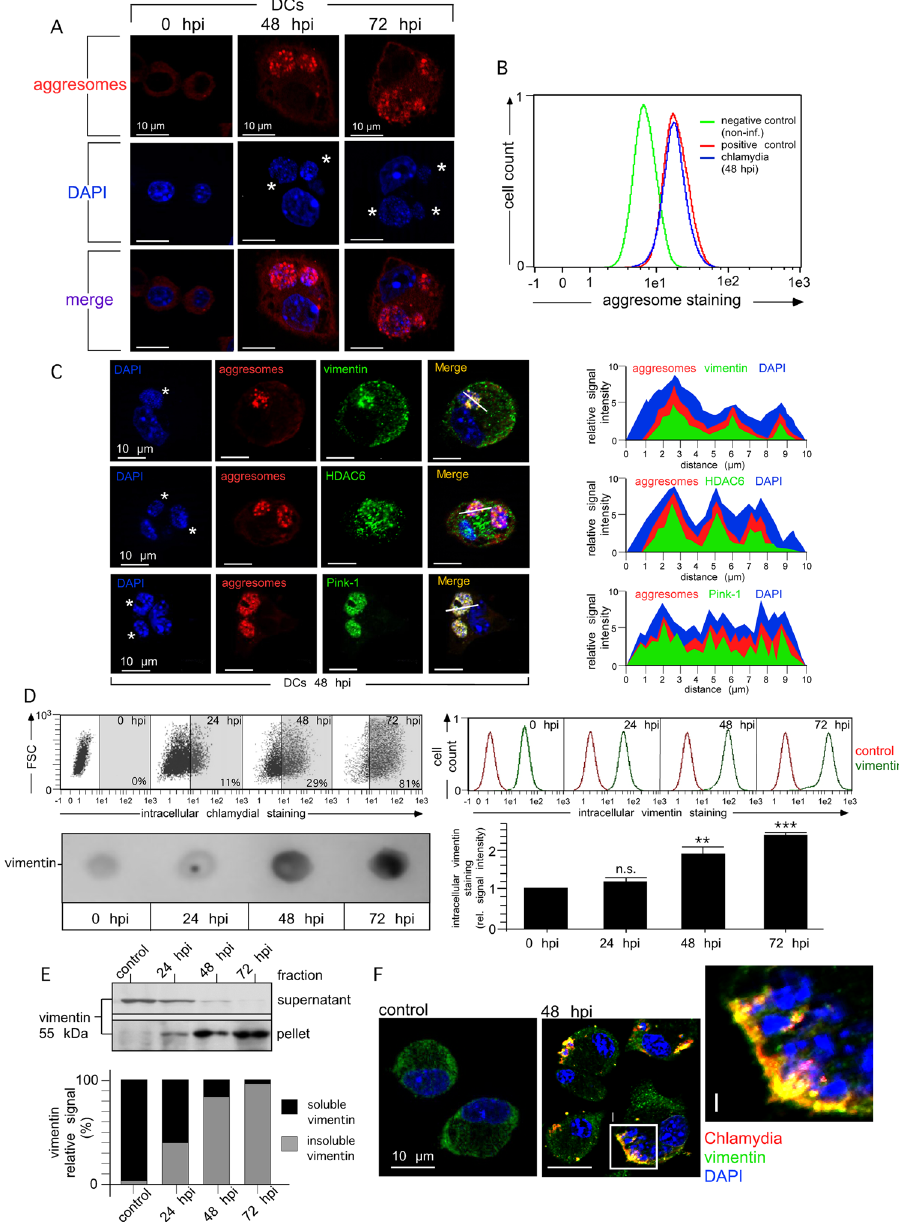
Figure 5. Disintegration of inclusions in DCs is accompanied by vimentin aggregation and aggresome formation around bacterial structures. ( A ) Aggresome formation in DCs (red) was analysed by using the Proteostat aggresome detection kit. DNA was visualised by DAPI (blue). Chlamydial structures are indicated by asterisks. ( B ) For aggresome detection by flow cytometry, DCs were infected or not with chlamydia. Positive control cells were treated with MG-132 for 18 h. Fluorescence profiles of positive control cells, infected and non- infected DCs (48 hpi) were overlaid. ( C ) Infected DCs (48 hpi) were costained for vimentin, HDAC6, Pink-1 (green) and aggresomal structures (red). DNA was visualised by DAPI (blue). The fluorescence intensity along a cellular cross section of interest was measured. Obtained profiles were overlaid and coloured. ( D ) Infected DCs were incubated with IMAGEN kit (upper left panel) or anti-vimentin antibody (upper right panel). Intracellular stainings are depicted as flow cytometry dot plot (upper left panel) and histogram (upper right panel), respectively. Data from the vimentin-staining experiment are summarised by bar graph (lower right panel). The MFI values of non-infected cells (0 hpi) were set to 1 arbitrary unit. A corresponding immuno-dot blot analysis of urea-extracted DCs is depicted in the lower left panel. ( E ) For the analysis of vimentin aggregation, infected DCs were lysed and centrifuged. Pellet and supernatant were analysed for the presence of vimentin in the same Western blot. The signal distribution (%) between soluble and insoluble vimentin was determined by densitometry (bottom panel). ( F ) DCs were infected or not for 48 h and costained for vimentin (green), chlamydial LPS (red) and DNA (blue). Statistical analysis in ( D ) was performed as described in Methods (n.s.: not significant; ** p < 0.01; *** p < 0.001 versus controls; n =